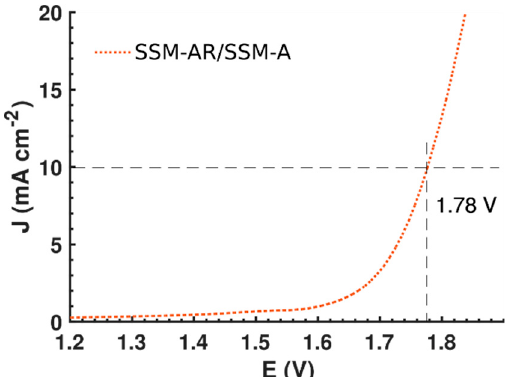
Figure 5. A LSV showing the performance for the full water splitting reaction, using SSM-A as the OER catalyst and SSM-AR as the HER catalyst. At a potential difference of 1.78 V (or an overpotential of 0.55 V) the two electrodes produce a current density of 10 mA/cm 2 . The scan rate for the LSV was 2 mV/s and it was conducted in 1.0 M KOH. The separation distance between the electrodes was 1 cm.